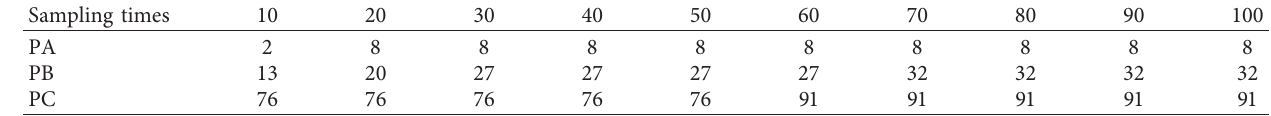
Table 4: The relationship between algorithm RANSAC sampling times and correct matching point pairs.